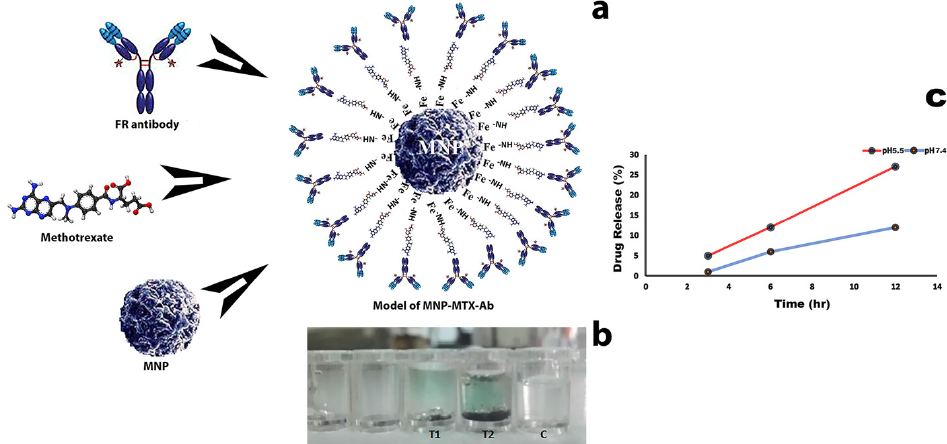
Figure 5. Schematic presentation, MagLISA and pH-dependent releasing behavior of MNP-MTX- FR Ab. ( a ) Schematic of conjugation of MTX on MNP and then FR antibody conjugation with nanocomposite on MTX. ( b ) MagLISA results. T 1 and T 2 are test wells, and C is the control well. ( c ) Drug releasing behavior at pH 5.5 and pH 7.4 at different time points.